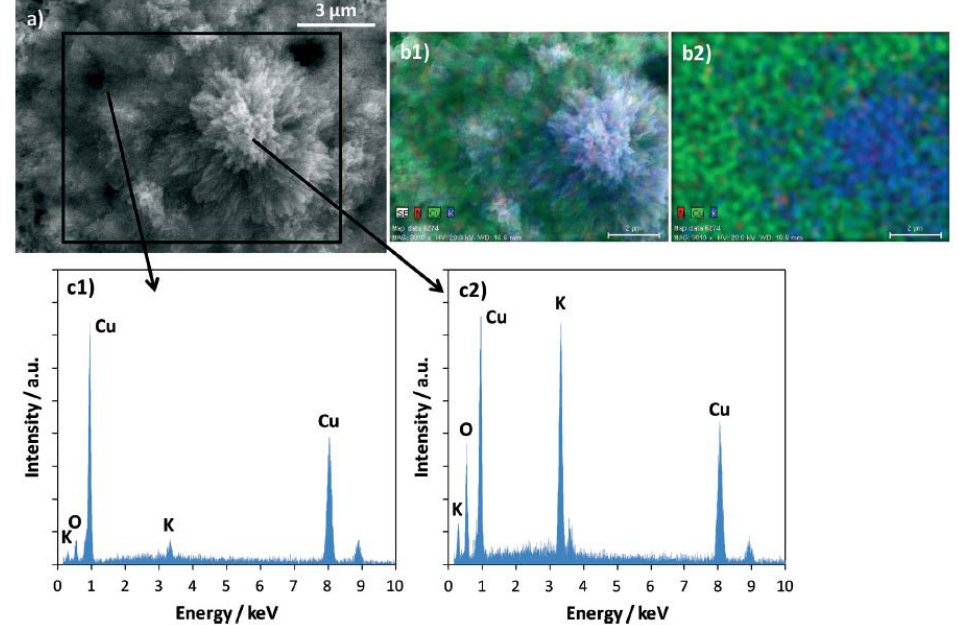
Figure 3. Top view SEM image of a selected area of a Cu/K- β Al 2 O 3 electrochemical catalyst ( a ) after the EPOC experiments (593 °C, CH 3 OH/O 2 = 4.4%/0.3%, V WR = −0.5 V for 1 h), along with the corresponding elemental mapping ( b1 and b2 ) of Cu (green), K (blue), and N (red) and the EDX spectra from different regions ( c1 and c2 ). Reprinted with permission from Ref. [32].